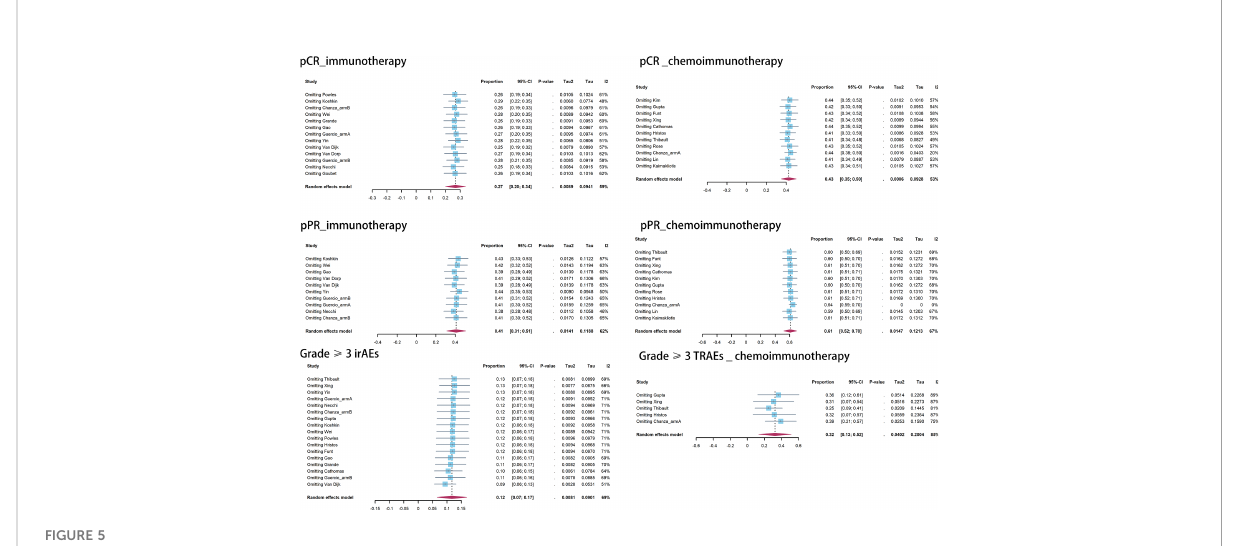
FIGURE 5 In fl uence analysis.